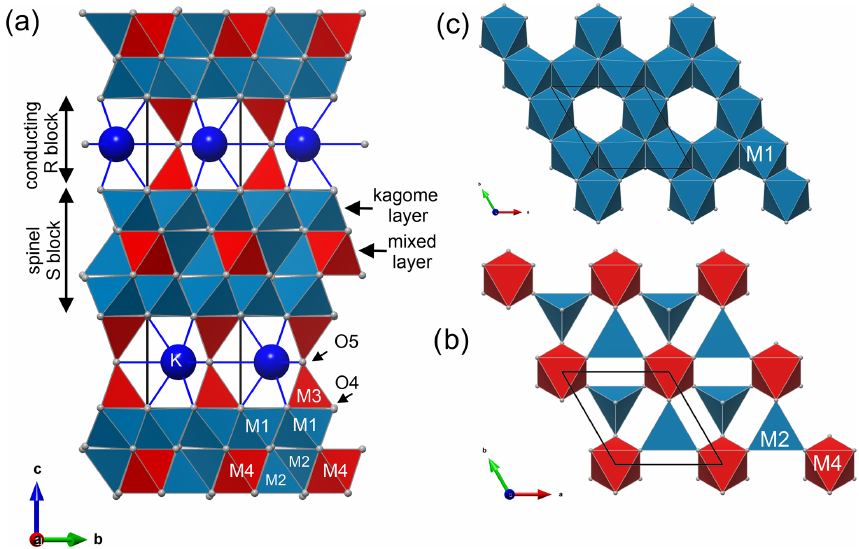
Figure 7. Structure of kahlenbergite. (a) Unit cell is made of two spinel (S) blocks and two conducting R blocks. Spinel blocks can be divided along c into mixed layers (b) and kagome layers (c) . In mixed layers AlO 6 octahedra (M4) and (Al 0 . 56 Fe 0 . 44 ) O 4 tetrahedra (M2) share corners. The kagome layer is built by edge-sharing (Al 0 . 92 Fe 0 . 08 ) O 6 octahedra (M1). Table 4. Kahlenbergite relative atomic coordinates and equivalent/isotropic displacement parameters. The M1 and M2 sites show a mixed Al and Fe